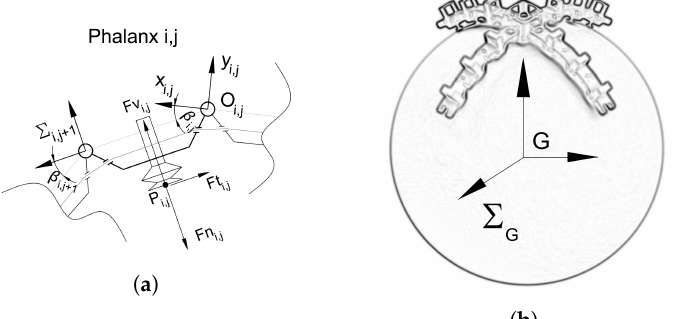
Figure 3. Schematic representation of reference frames used to develop the theoretical model with reference to the single phalanx ( a ) and object under grasp ( b